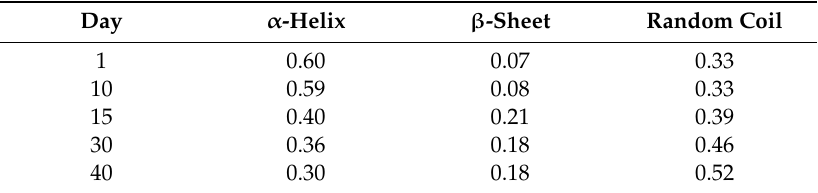
Table 2. Secondary structure content of BSA prior to and after gold nanoparticle formation and growth, as evidenced by circular dichroism. Day α -Helix β -Sheet Random Coil 1 0.60